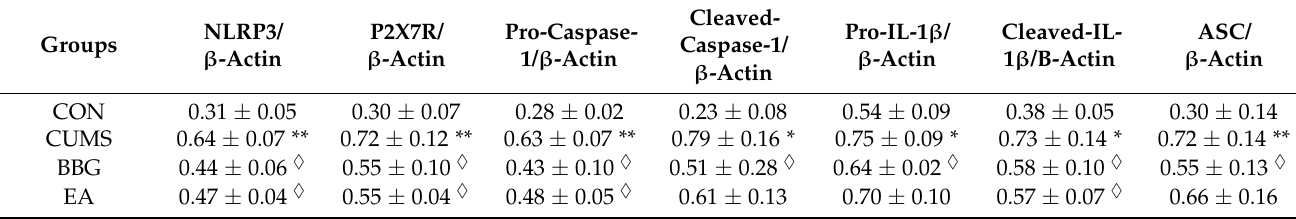
Table 7. Effects of EA on the expression of P2X7R, NLRP3, and IL-1 β related protein in the liver of CUMS